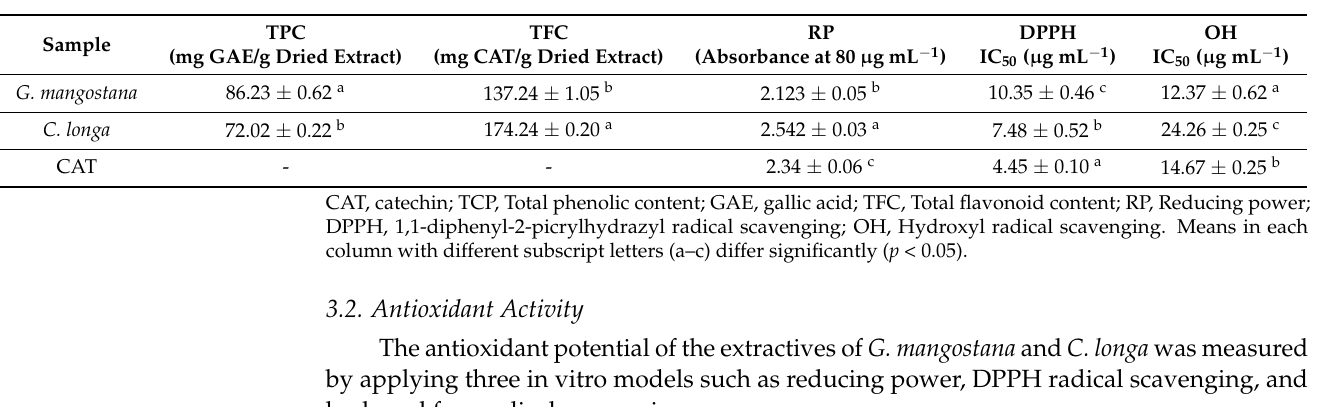
Table 2. Estimation of total phenolic and flavonoid content and antioxidant activity of the methanol extracts of G. mangostana pericarp and C. longa